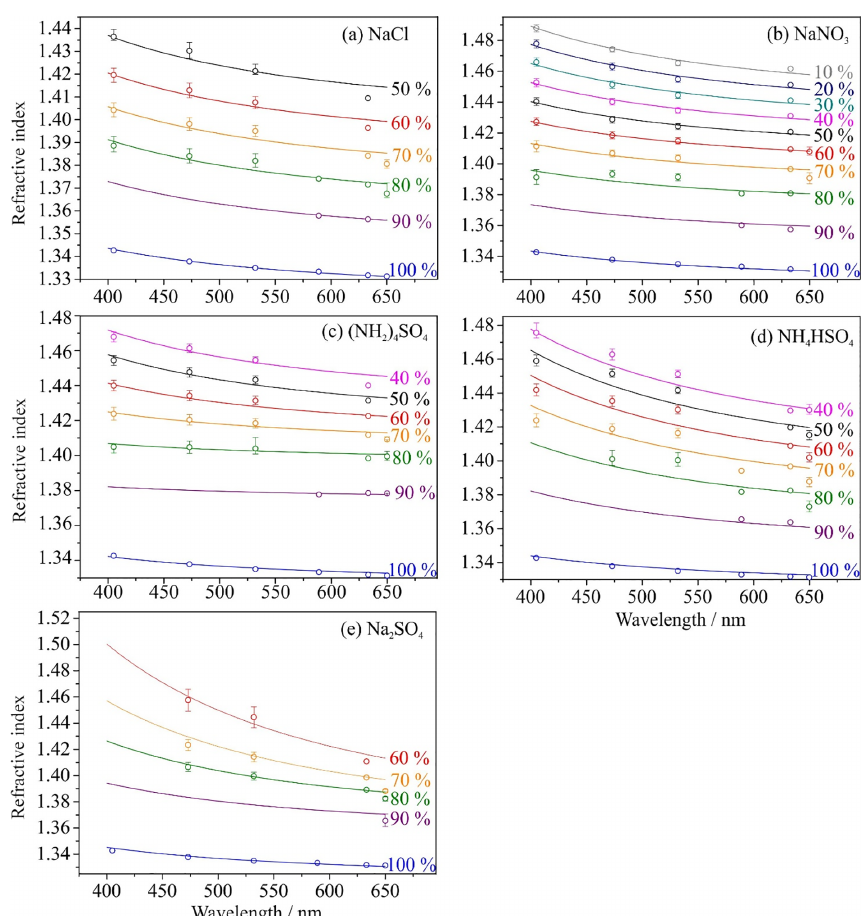
Figure 8. The best-fit Cauchy dispersion curves (solid lines) for measured and literature RI data (points) shown at 10% RH intervals (labels). The parameterisations were fitted to data at 2% RH intervals, and the total numbers of data points included in the parameterisation are specified in Table 2. The curves are found by a global fit of the Cauchy dispersion model (Eqs. 7–9) to the measured and literature data in Fig. 5 using the procedure described in the text. The error bars represent the uncertainty in the RH measurements, indicated in the text, in the RI